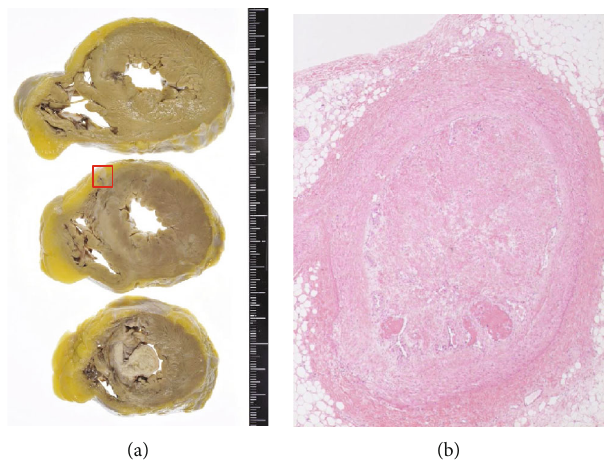
Figure 4: The heart has myocardial infarction from the septum to the lower wall of the (a) ventricle. There is a mural thrombus in the lumen at the apex. The red frame is the anterior descending branch, in which obstruction and recanalization with organization due to thromboembolism are seen ((b) x40).